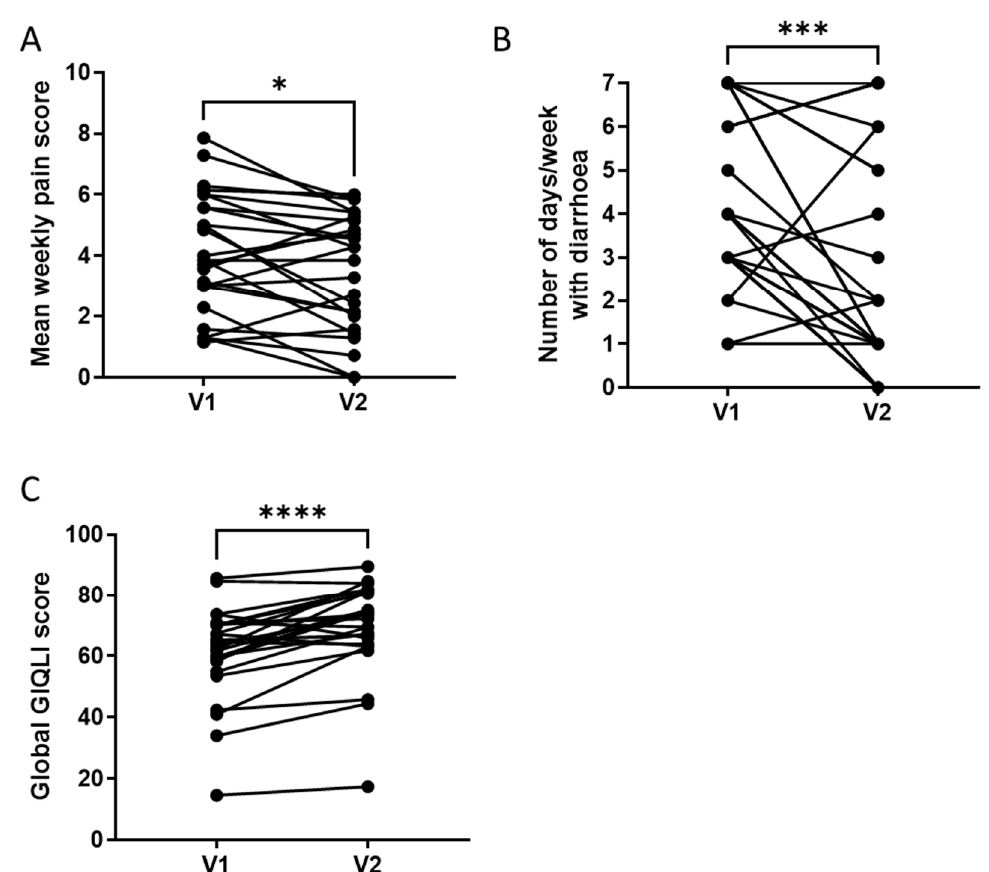
Figure 2. Clinical response to a 4-week supplementation with the multistrain probiotic in the per- protocol population. ( A ) Decrease in mean weekly abdominal pain score between V1 and V2. Paired t -test; *: p < 0.05; ( B ) decrease in mean number of days per week with diarrhoea (score of 6 or 7 on